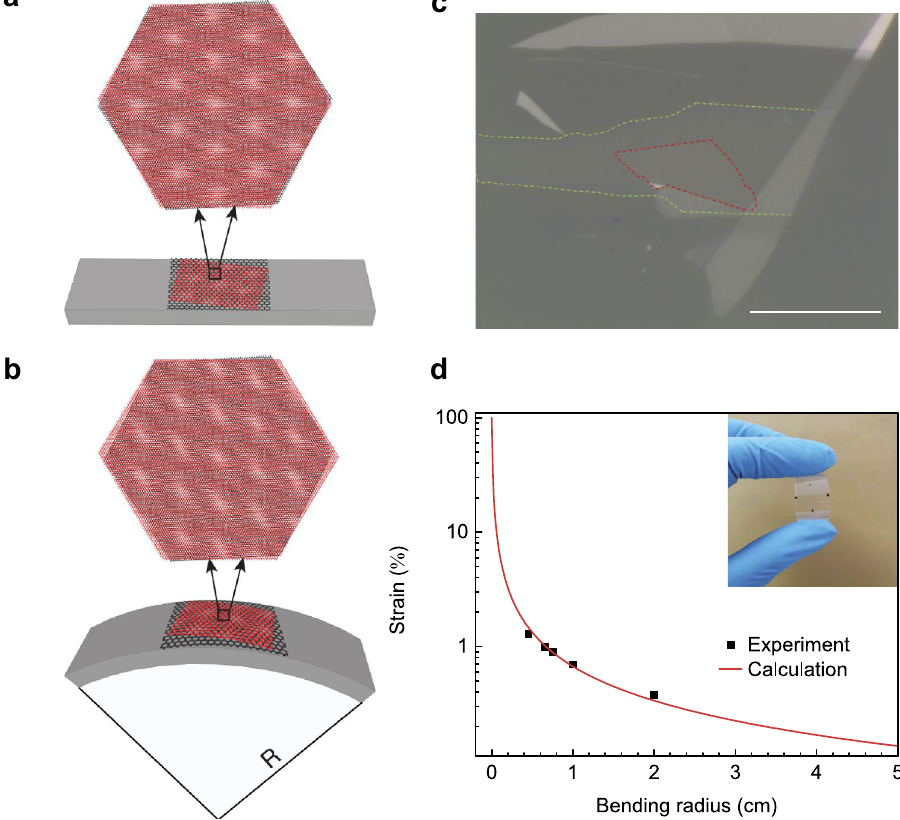
Figure 1. Heterostrain-enabled dynamically tunable moiré superlattice in TBG. ( a , b ) Schematic illustration of dynamically tunable moiré superlattices in TBG on a flexible substrate before and after bending. ( c ) Optical microscope image of the TBG device with a 13.2° twist angle used in our study. Scale bar, 20 μm. ( d ) Calculated (red line) strain on PET surface and experimental (black squares) uniaxial strain in bottom graphene. Thickness of our PET substrate is 135 μm. Inset: photo showing the flexibility of our substrate with the TBG device on